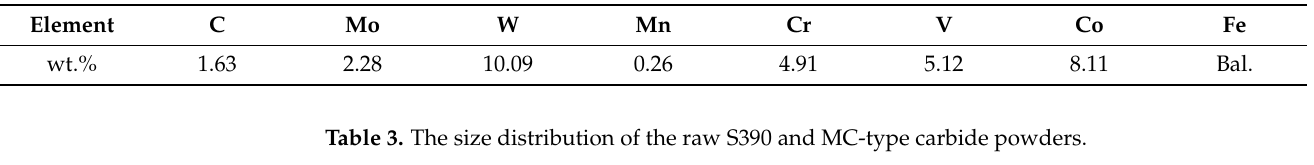
Figure 1. The SEM secondary electron (SE) micrographs of raw powders. ( a ) HSS, ( b ) SiC, ( c ) TiC, and ( d ) VC. Table 2. The chemical composition of the S390 HSS powders.